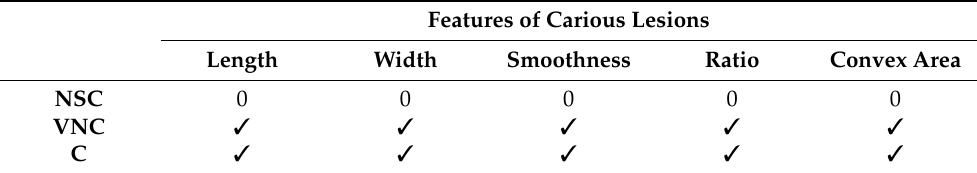
Table 2. Features used for building the proposed predictive models.